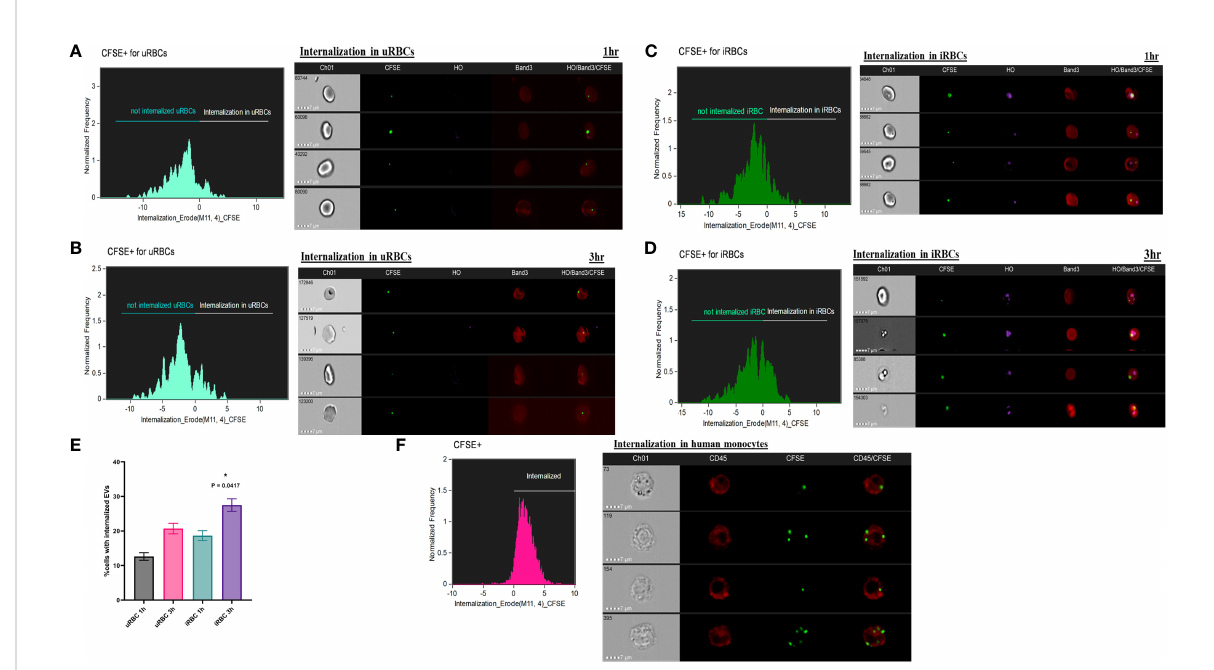
FIGURE 3 Internalization of carboxy fl uorescein succinimidyl ester (CFSE) – labeled extracellular vesicles (EVs) by red blood cells (RBCs) and monocytes. (a – e) 50 m g of puri fi ed EVs from spent culture supernatant of B. divergens – infected RBCs (iRBCs) were CFSE (green) labeled. These were incubated with iRBCs at 35% parasitemia for 1 and 3 h and stained with Band3-APC (red) and Hoechst (pink). ImageStream was performed followed by the application of Internalization Wizard of IDEAS ™ software. In the histogram obtained, cells above zero are “ internalized, ” whereas those below are “ not internalized. ” Gating strategy is elaborated in Supplementary Figure 2 under Supplementary File 4. (A, B) The histograms show internalization of CFSE-EVs in uninfected RBCs (uRBCs) (Band3+, HO − ) at 1 and 3 h, respectively. Representative images of internalized EVs are shown. (C,D) The histograms show internalization of CFSE-EVs in iRBCs (Band3+, HO+) at 1 and 3 h, respectively. Representative images of internalized EVs are shown. (E) Quanti fi cation of percent cells with internalized EVs reveals that a marginally higher percentage of